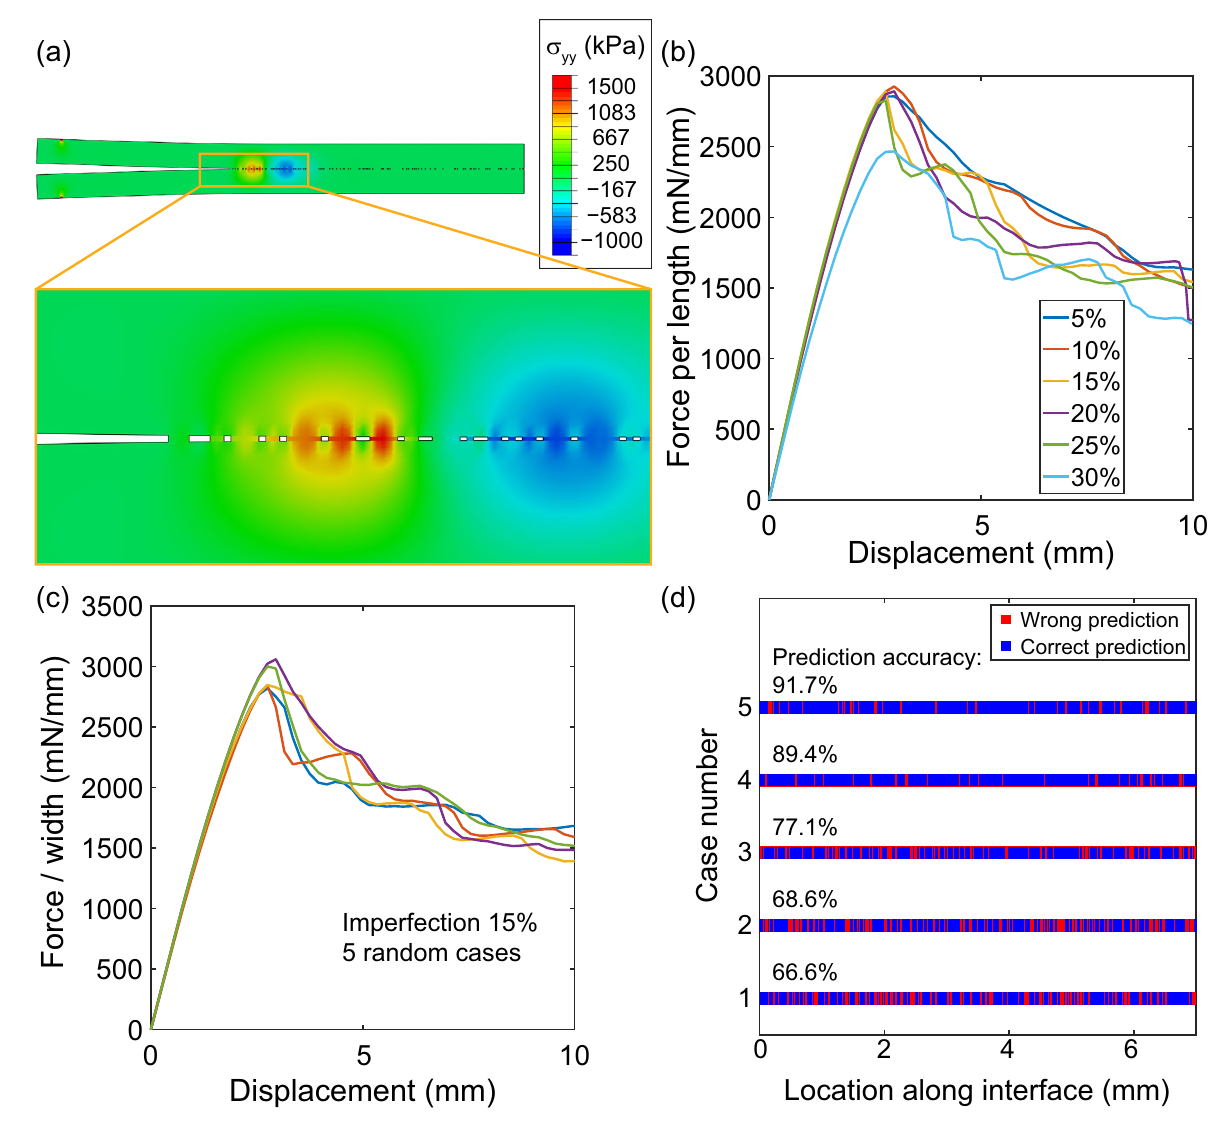
Figure 5. Prediction of interfacial imperfection by machine learning. ( a ) An example of stress distribution at interface with imperfections in a FEA DCB test. Force–displacement curves obtained from cases with ( b ) different imperfection ratio and ( c ) different locations of imperfections. ( d ) Examples of imperfection locations predictions using XGBoost classifier. The average prediction accuracy is 80.9% over 312 testing